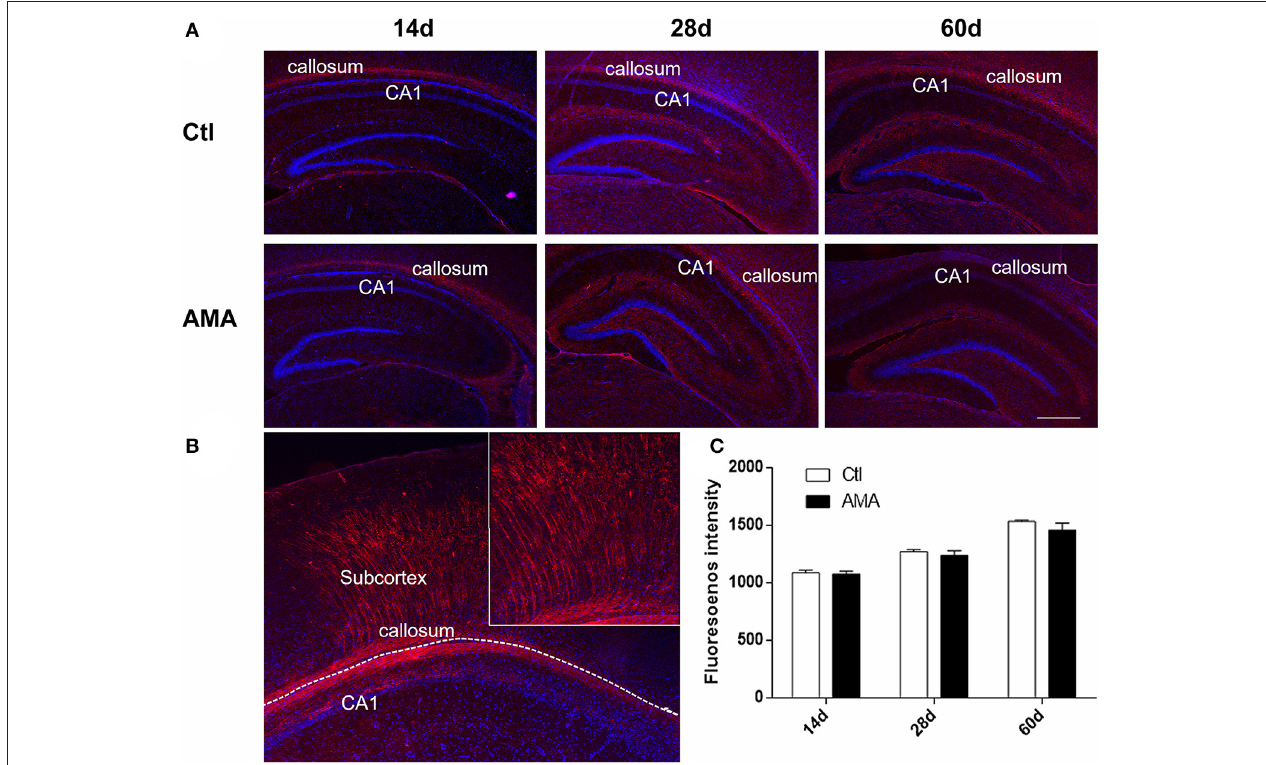
FIGURE 2 | Immunofluorescence of MBP in the AMA and control groups. (A) Immunofluorescence showing the protein expression of MBP in hippocampal tissue samples collected from rats on P14, P28, and P60. (B) The shape of the MBP in the CA1, callosum and subcortex. (C) Quantitative analyses of the intensity of MBP-positive cells at different times for each group. The scale bar is 100 µ m. Data are expressed as the mean ± SEM ( n = 5 rats in each